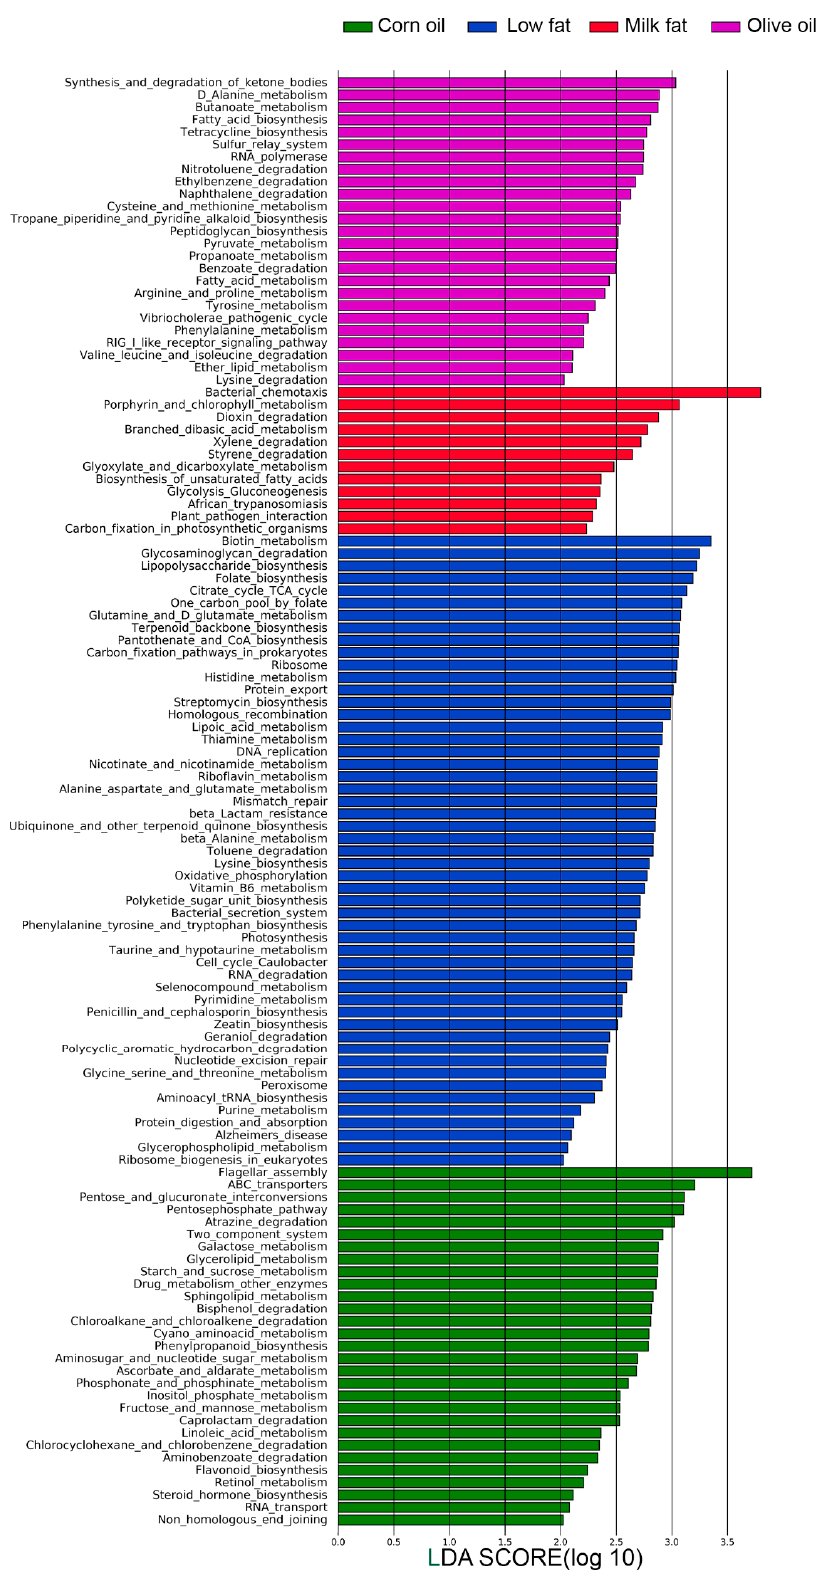
Figure 3. The effect of lipid diets on predicted microbial functions. Statistically and biologically differentially abundant pathways amongst the four dietary group shown as a histogram of the LDA scores. The length of the bars represents a log10 transformed LDA score set to a threshold value of 2. The one-to-all version of LEfSe was used with Kruskal–Wallis test ( P <